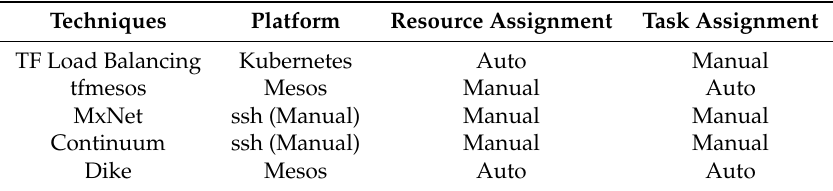
Table 2. Status quo of current deep learning